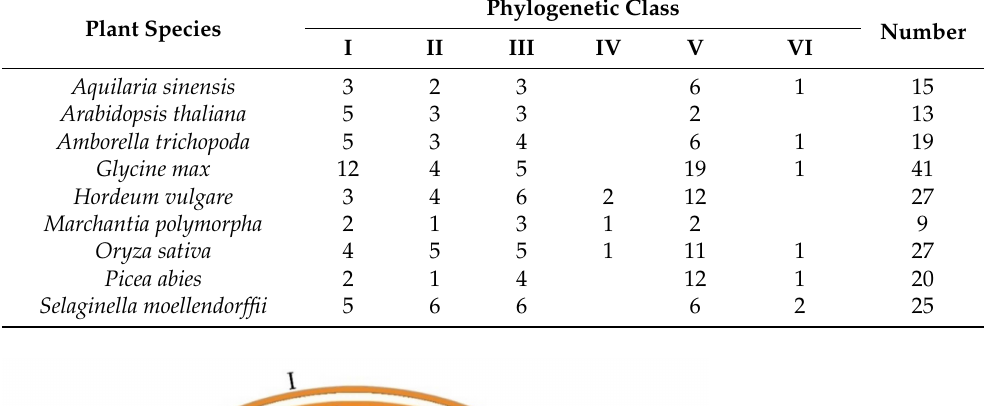
Table 2. HSP70 family members in selected plant species.